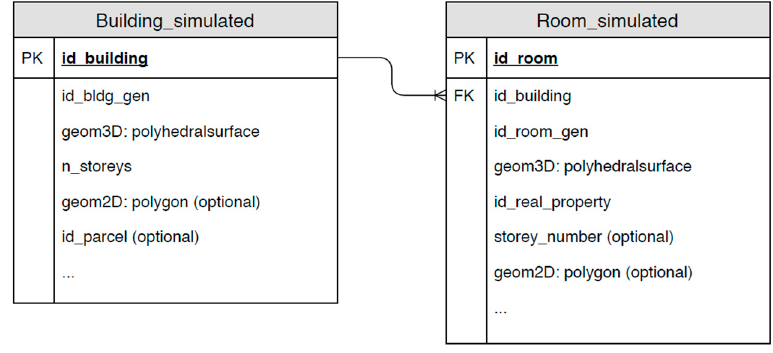
Figure 9. DBMS storage for the simulated 3D cadastral dataset.